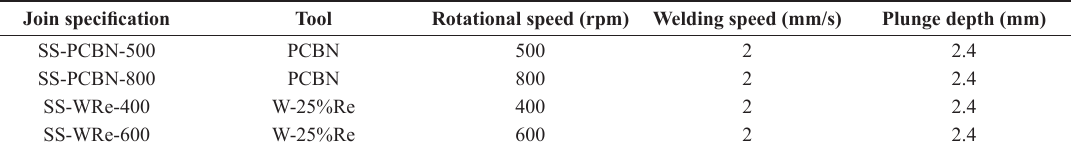
Table 2. Parameters specifications.